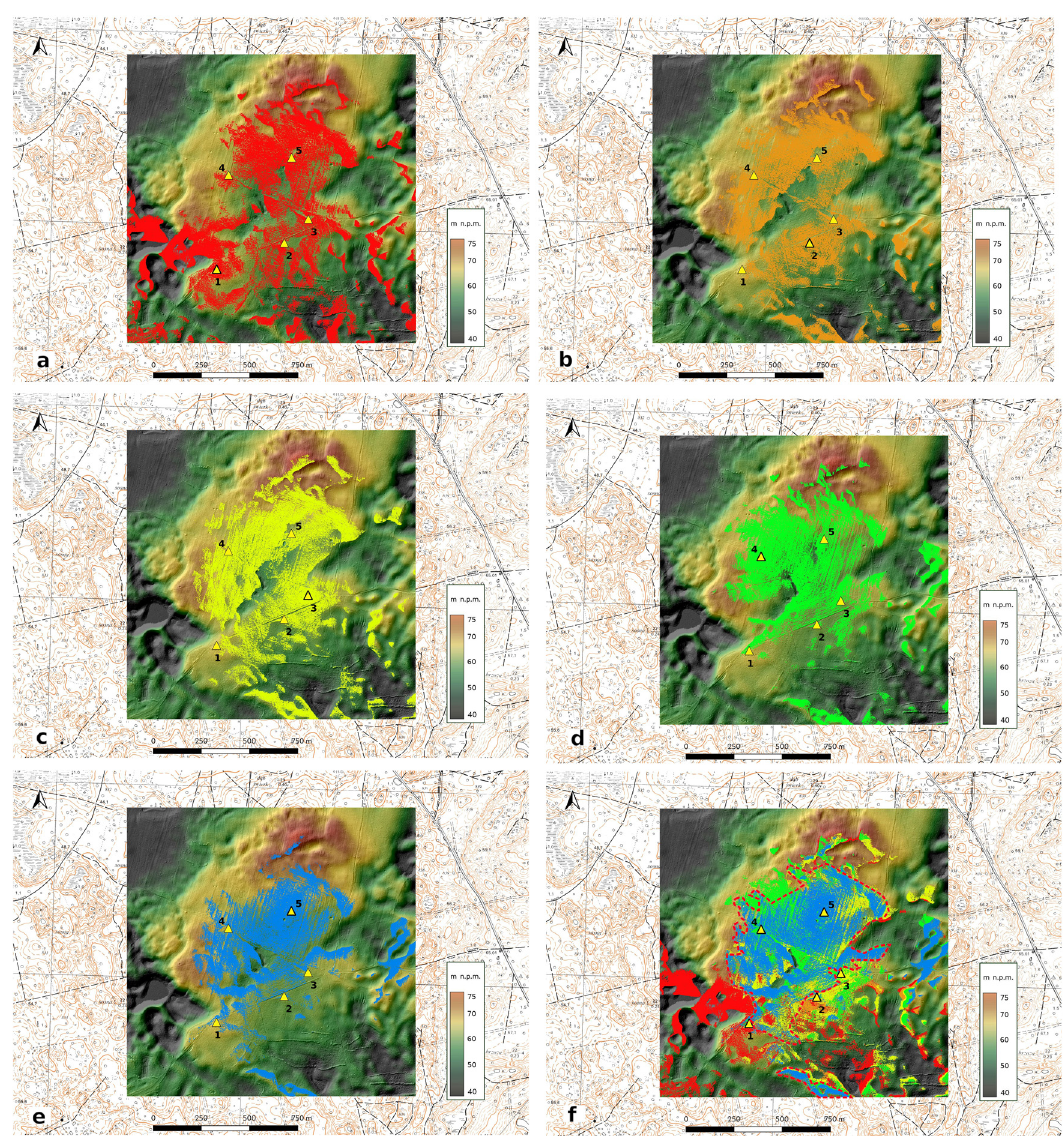
Figure 8: The Dolice - Rondo Lucjana megalithic group. The area visible from the tombs 1 ( a ) , 2 ( b ) , 3 ( c ) , 4 ( d ) , 5 ( e ) and the juxtaposed views ( f ) . The area visible from all megalithic tombs is marked with a red line ( M. Schiller )